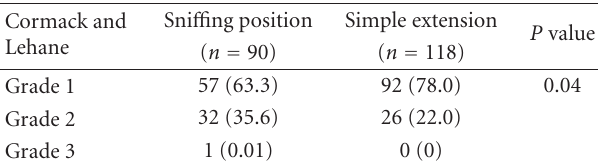
Table 3: Comparison of views obtained during laryngoscopy following external laryngeal manipulation.